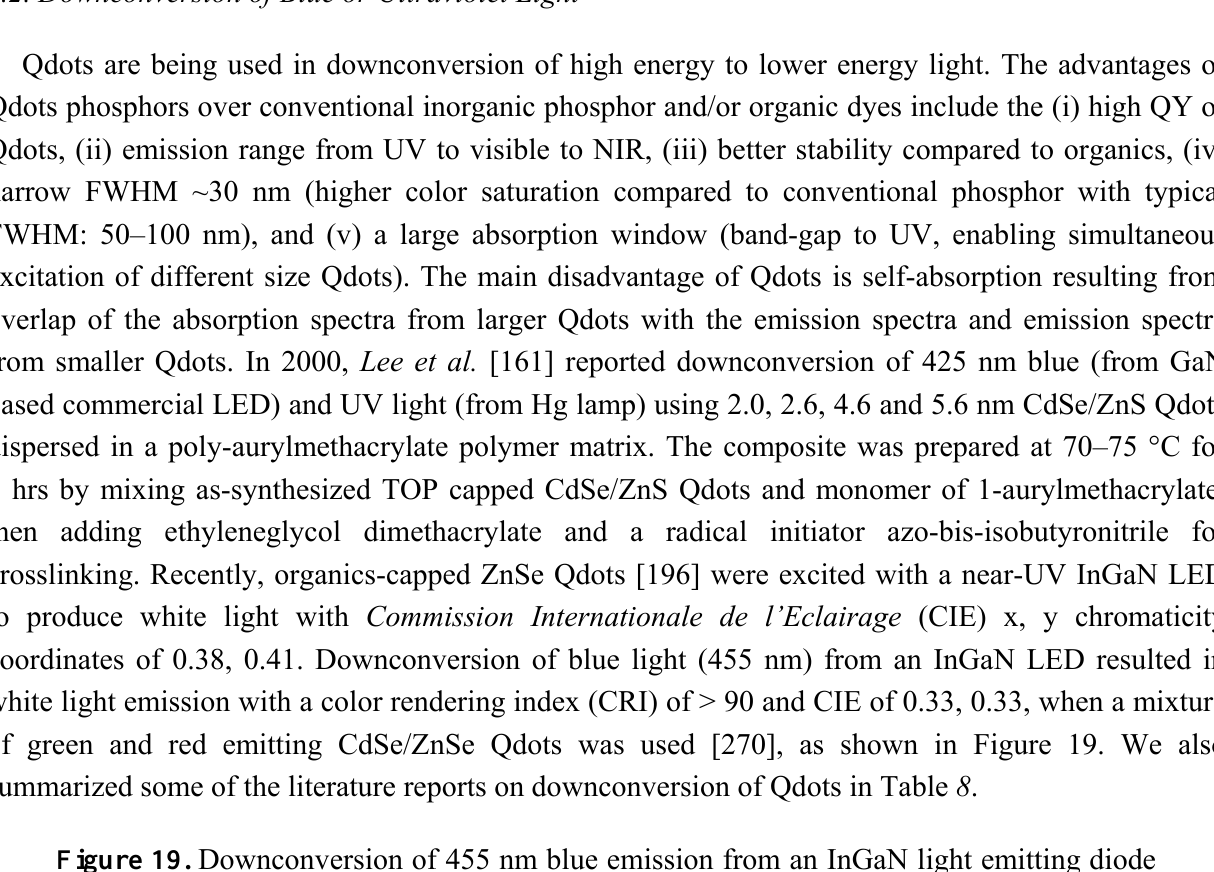
Figure 19. Downconversion of 455 nm blue emission from an InGaN light emitting diode to green and red by size-tuned CdSe/ZnSe Qdots in a silicone matrix (color rendering index: 91; chormacity coordinate: 0.33, 0.33) [reprinted with permission from [270] (© 2006